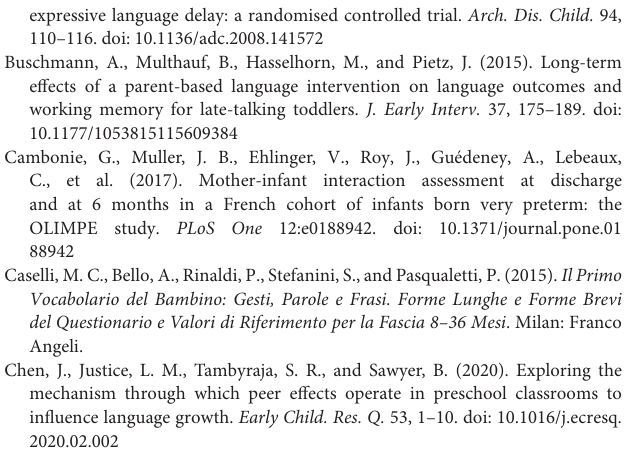
Supplementary Figure 1 | Flow diagram of late talkers whose parents participated in the study. Supplementary Figure 2 | Parental changes in expansions (models IV and V) and talking over reading (models VII and VIII) as mediators of the parent-implemented intervention effect on child’s speech types and tokens. Supplementary Table 1 | Clinical and Perinatal Characteristics of the Low-Risk Preterm Children. Supplementary Table 2 | Descriptive statistics of parental and child’s speech measure at the pre-intervention assessment for the intervention and the control group. The table also summarizes the results of multivariate MANCOVAs addressing groups differences at pre-intervention. Supplementary Table 3 | Pearson’s correlation coefficients among study’s variables of change in parental and child’s